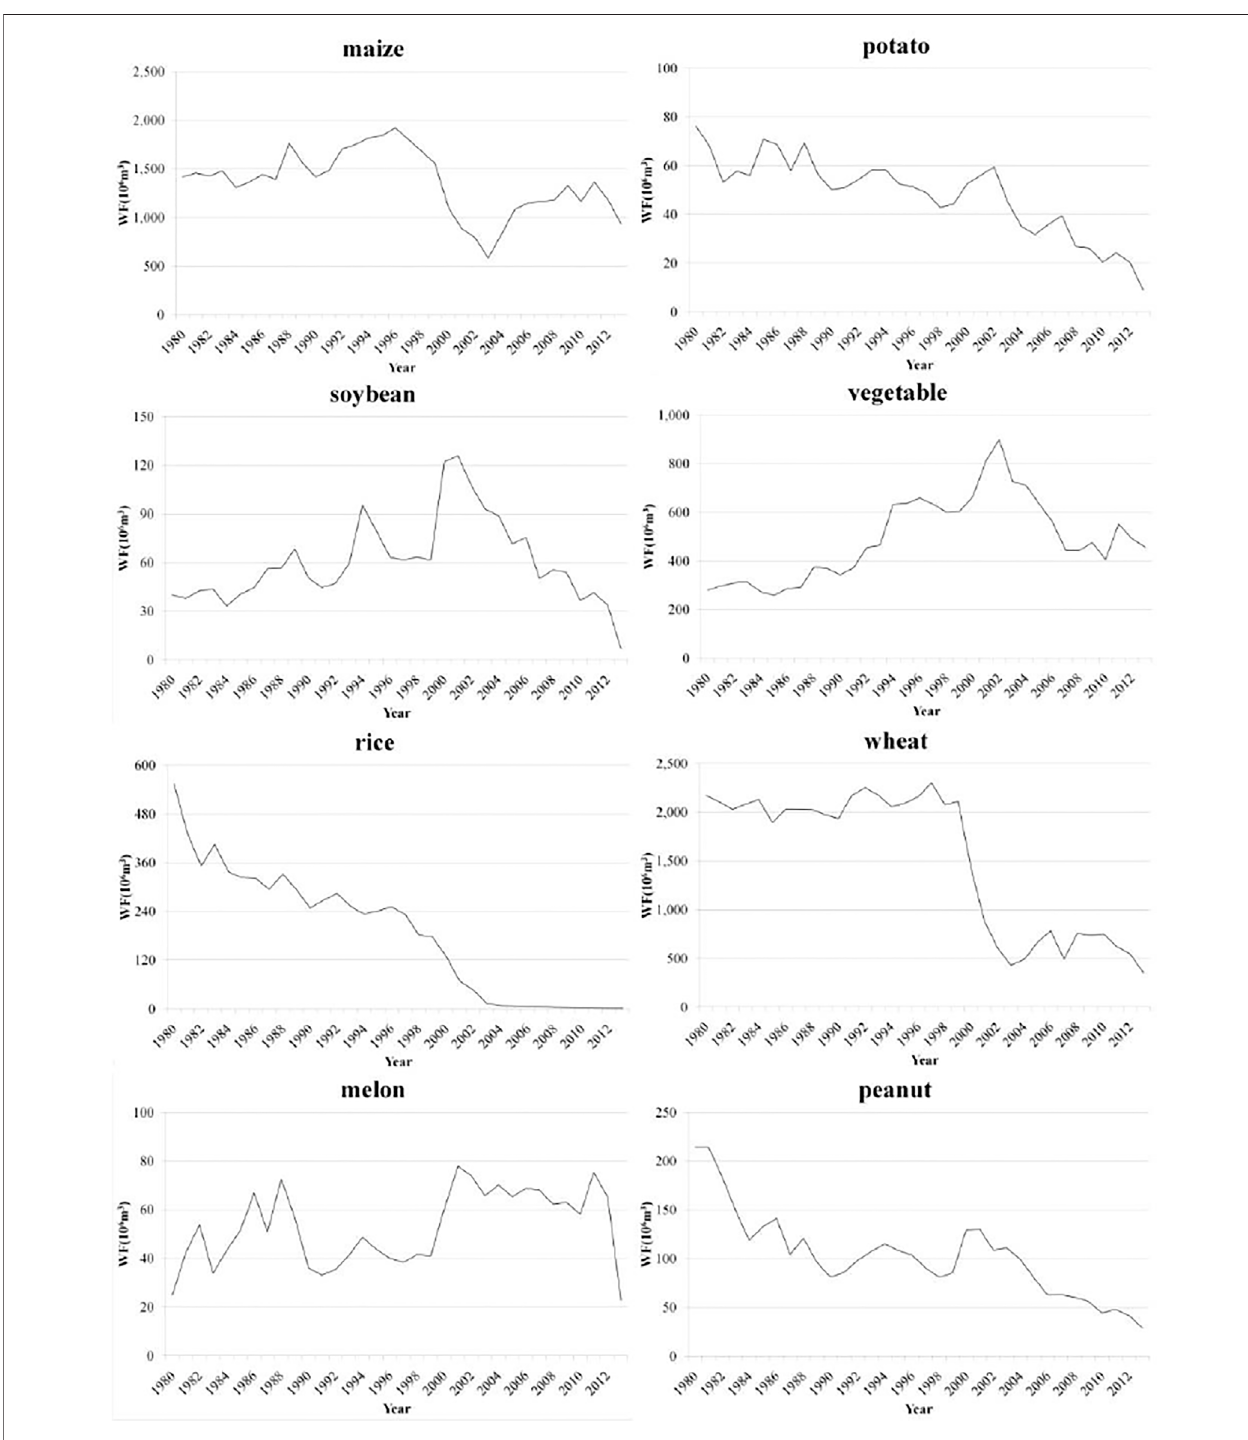
FIGURE 1 | Changes in the crop WF in Beijing from 1980 to